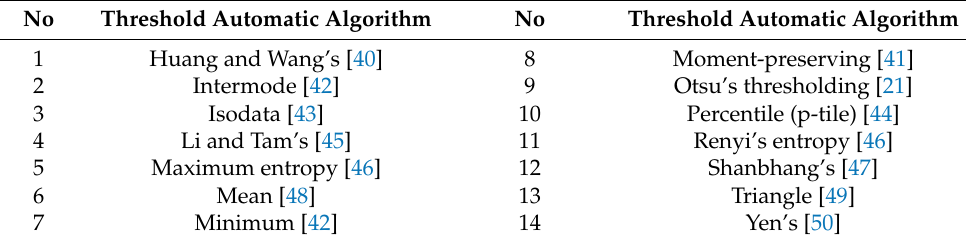
Table 3. Thresholding methods applied in the